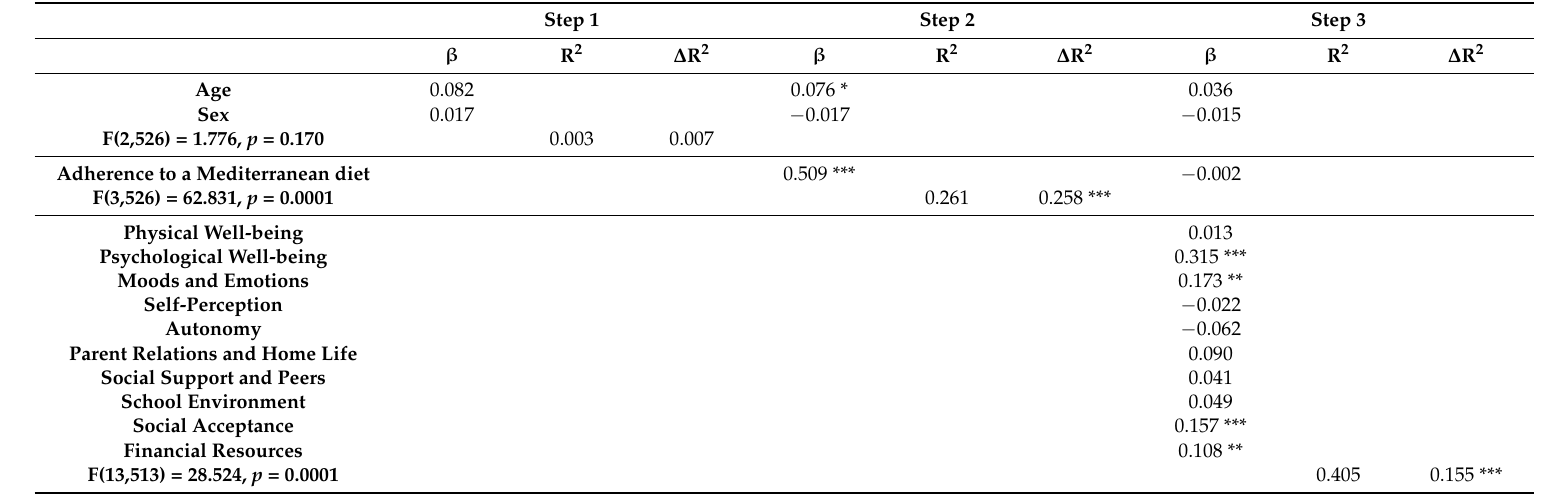
Table 2. Predictive value of adherence to a Mediterranean diet (MD) and health-related quality of life on subjective happiness controlling for age and